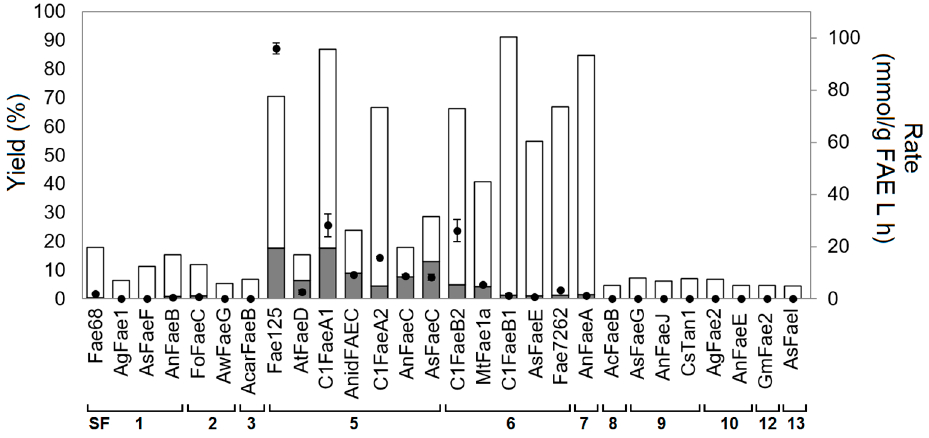
Figure 3. Synthesis of AFA. Reaction conditions: 50 mM VFA, 50 mM L -arabinose, 0.1 mg protein mL − 1 , 19.8:74.7:5.5 v / v / v n -hexane: t -butanol: buffer, 45 °C, no agitation, 8 h of incubation. Grey column: transesterification yield; white column: hydrolysis yield; black circle: specific rate of transesterification. The error bars represent the standard deviation between two duplicates.